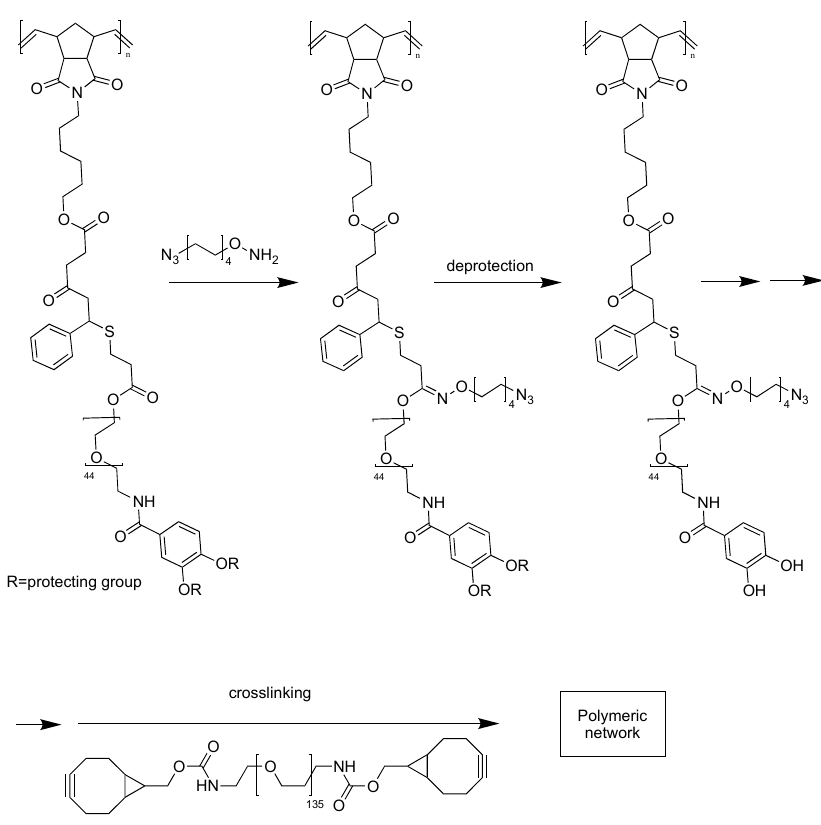
Figure 1. Incorporation of catechol groups in a polymeric network. Adapted and re-drawn from [15].